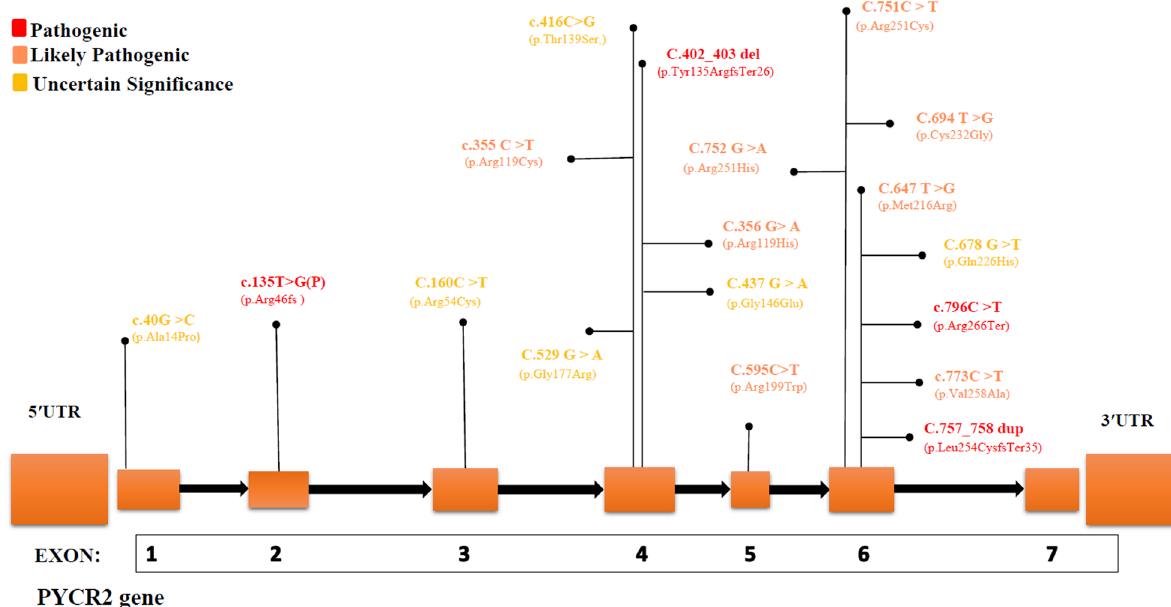
Fig. 5 Schematic representation of the identified variants in PYCR2 gene